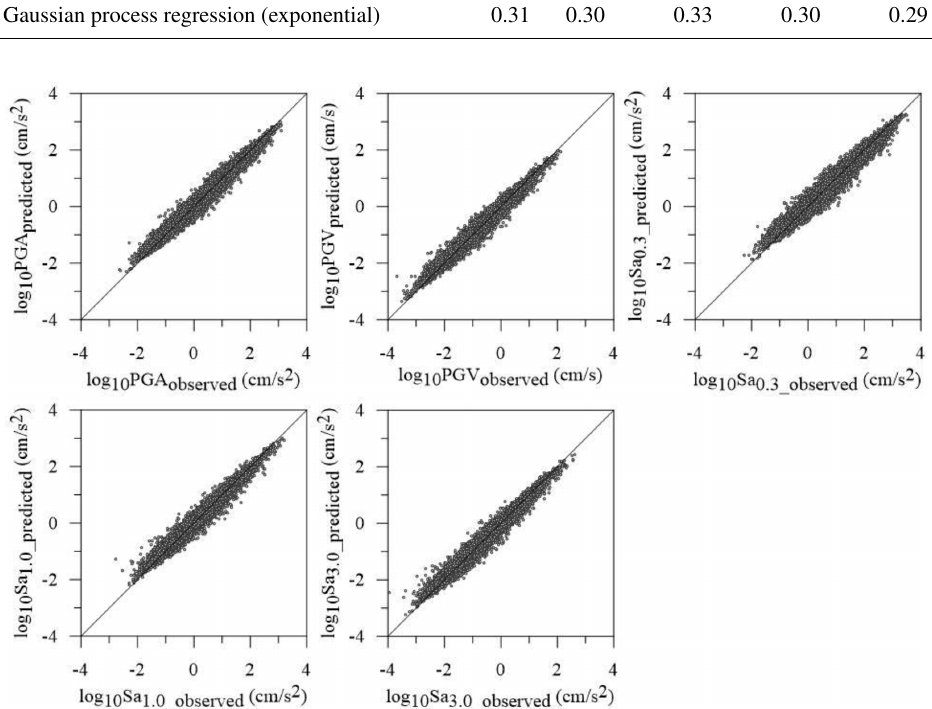
Figure 5. Comparison between observed and predicted values referring to the output data (i.e., geoH in terms of PGA, PGV, Sa 0 . 3 , Sa 1 . 0 , and Sa 3 . 0